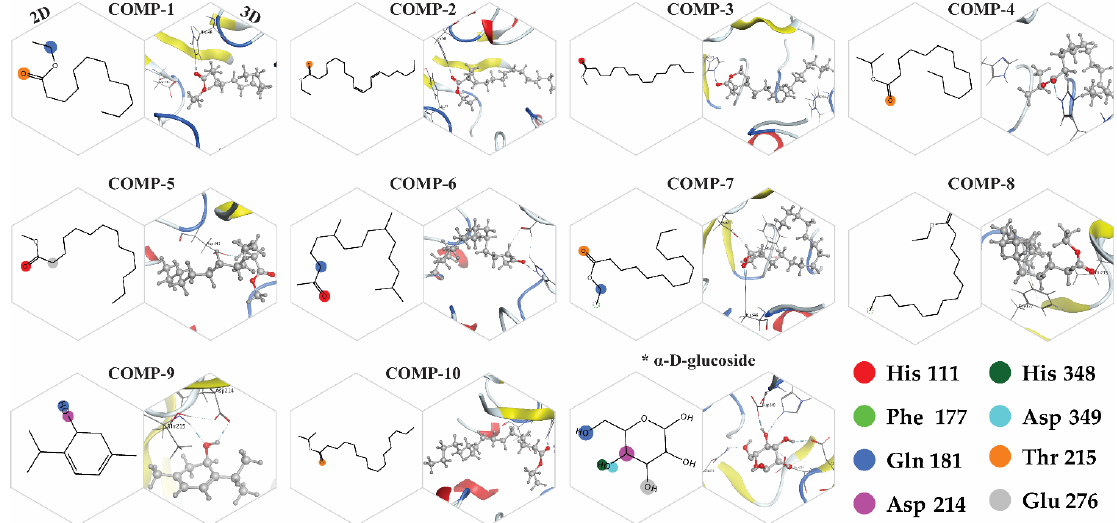
Figure 12. Two-dimensional and three-dimensional interaction representation of the selected 10 inhibitors having a reference substrate (alpha-D-glucose) with the active pocket residues of the α -glucosidase protein. The interactive atoms of each compound with a specific residue are colored as the residue assigned color in the 2D representation. * The alpha-glucosidase protein substrate ( α -D-glucose) interaction with active site residues.